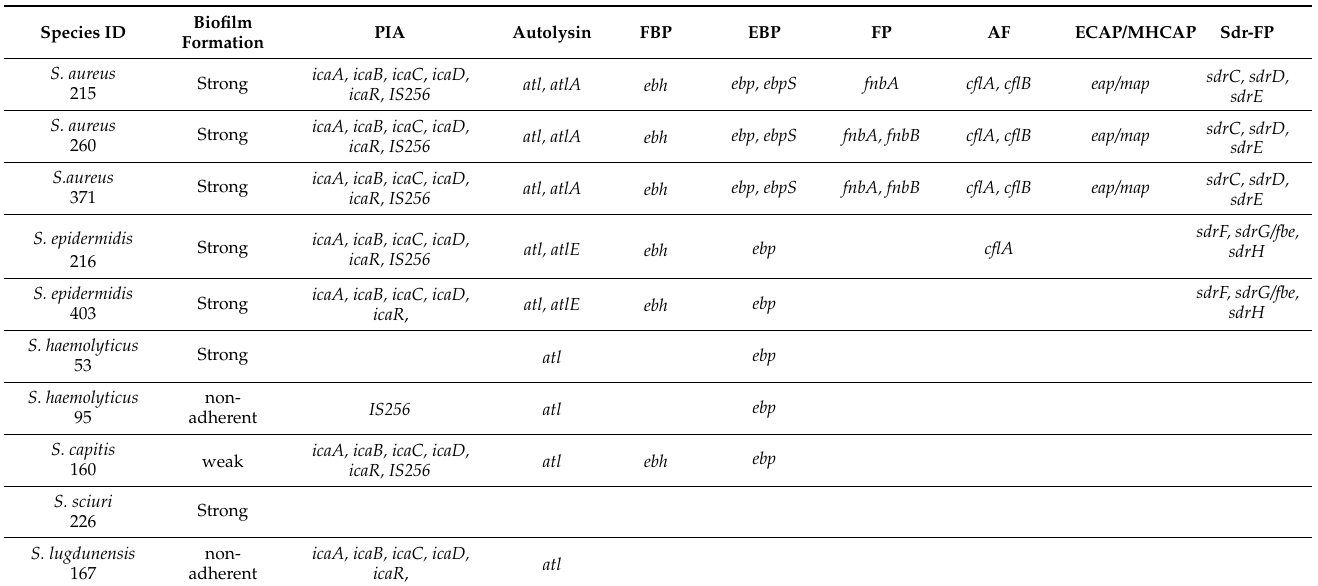
Table 5. Evaluation of phenotypic biofilm formation and detection of biofilm forming genes and adhesins (MSCRAMMs) of clinical